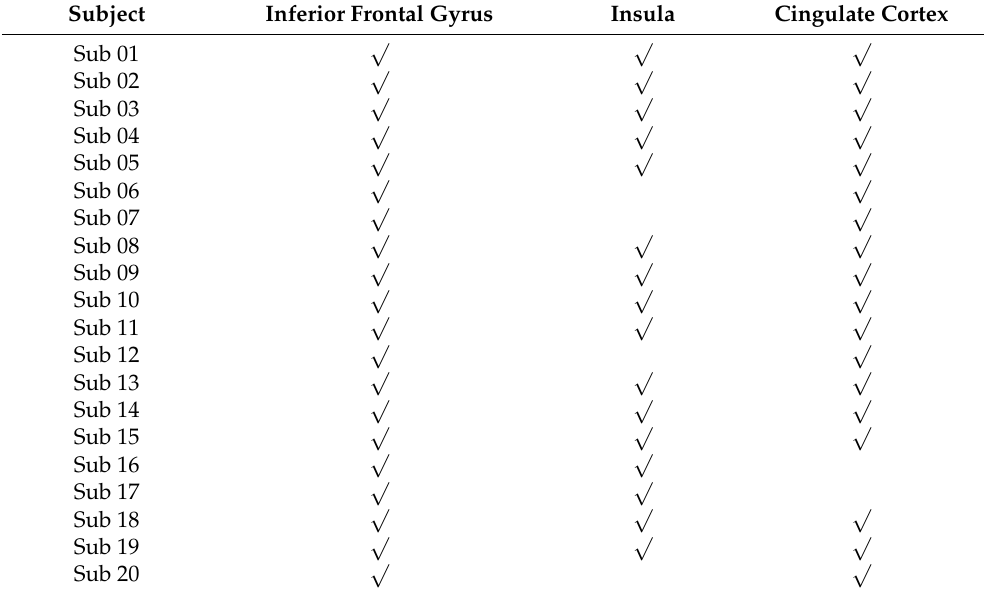
Table 4. Partial activated ROIs of all subjects of losing